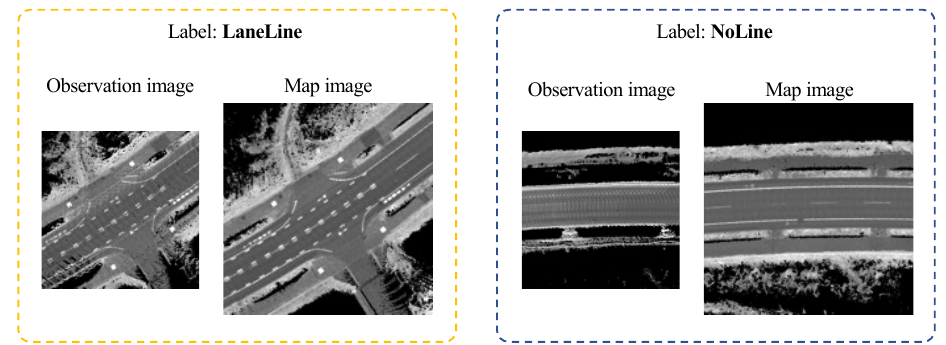
Figure 11. Exapmles of training